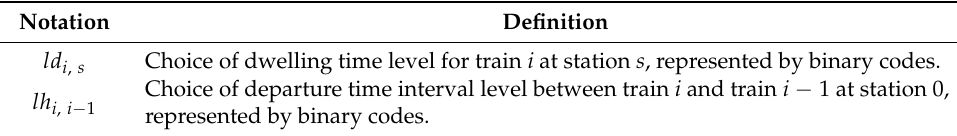
variables involved in this problem are the choices of the intervals’ level and the dwell time level for each train at different stations, and binary codes could represent these choices. For clarity, the detailed definitions of decision variables are listed in Table